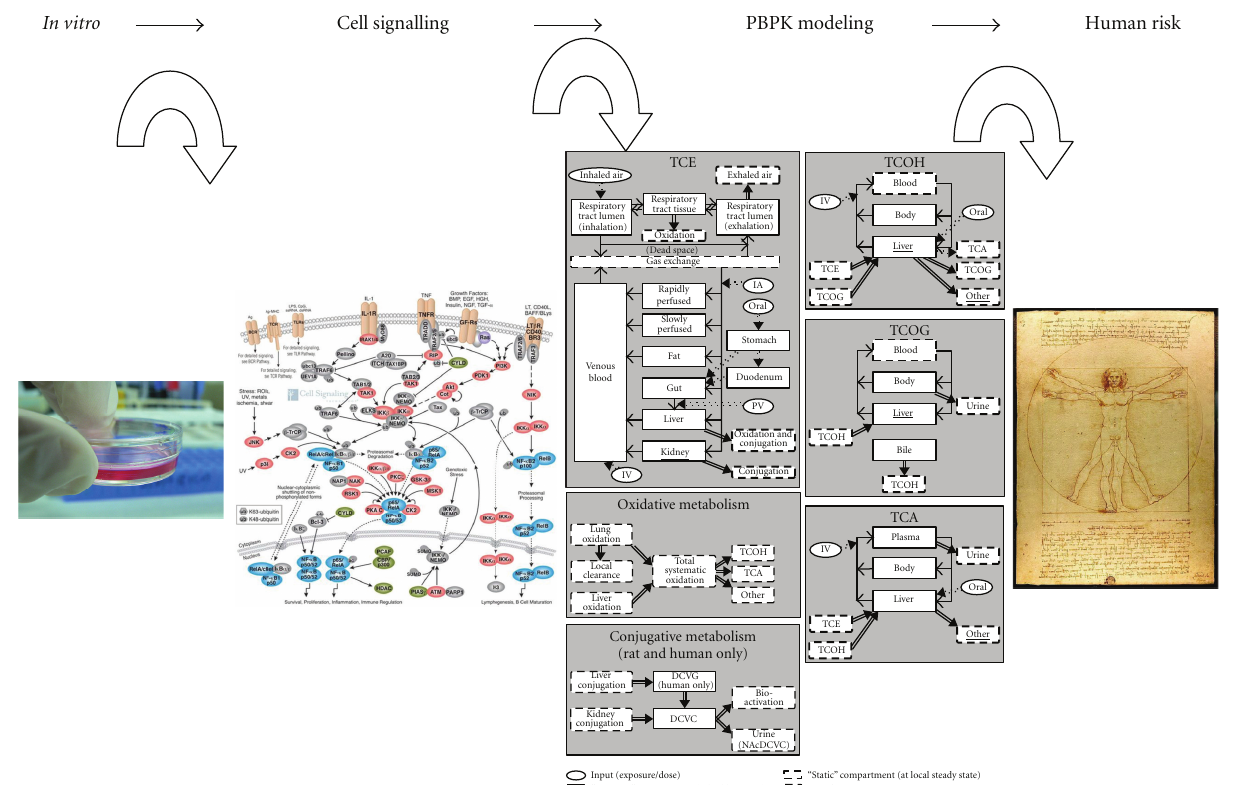
Figure 1: This figure represents, in simplistic fashion, major extrapolations between data that has been derived from in vitro isolated cell systems to interpretations of that data for cell-signaling pathways, the extrapolation of cell signaling results in regard to PBPK models that assign appropriate dose metrics and target organ concentrations, and finally the prediction of human risk from resulting models for a particular xenobiotic